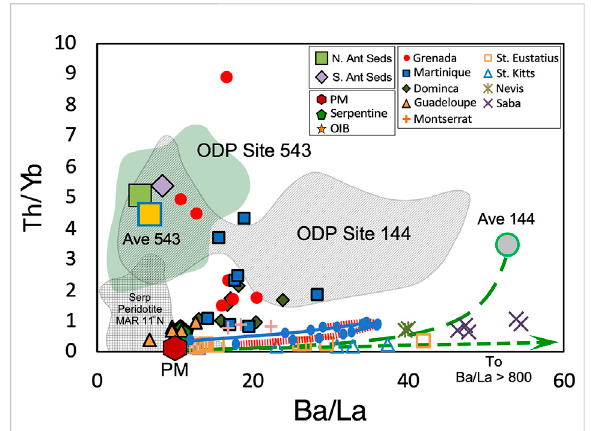
FIGURE 12 Abundance of Ba/La ( fl uid component) vs. Th/Yb (sediment component)forLAIAwholerocksamples.Grenadasamplesfollow someMartiniqueandDominicawholerocksamples.Samplesfrom Nevis, St. Kitts, St. Eustatius and Saba follow a distinct high Ba - low Th trend towards an ultra-high Ba/La endmember. Samples from Guadeloupe, Montserrat and a few samples form Martinique and Guadeloupe also trend towards high Ba/La but with more elevatedTh/Yb. Blue and red lines areAFC models (DePaolo, 1981) at F = 5% melting with varying r (red dashed line) and r = 0.8 with varying F (blue solid line) using a bulk D close to that described by Hu et al. (2021) after Labanieh et al. (2010) but extrapolated for the general assemblage of the arc with a starting composition equivalentto theaverageofallSite 144sedimentsfromCarpentier (2007). Green dashed line is binary mixing (Langmuir, 1978) of primitive mantle (PM; Sun and McDonough, 1989) with